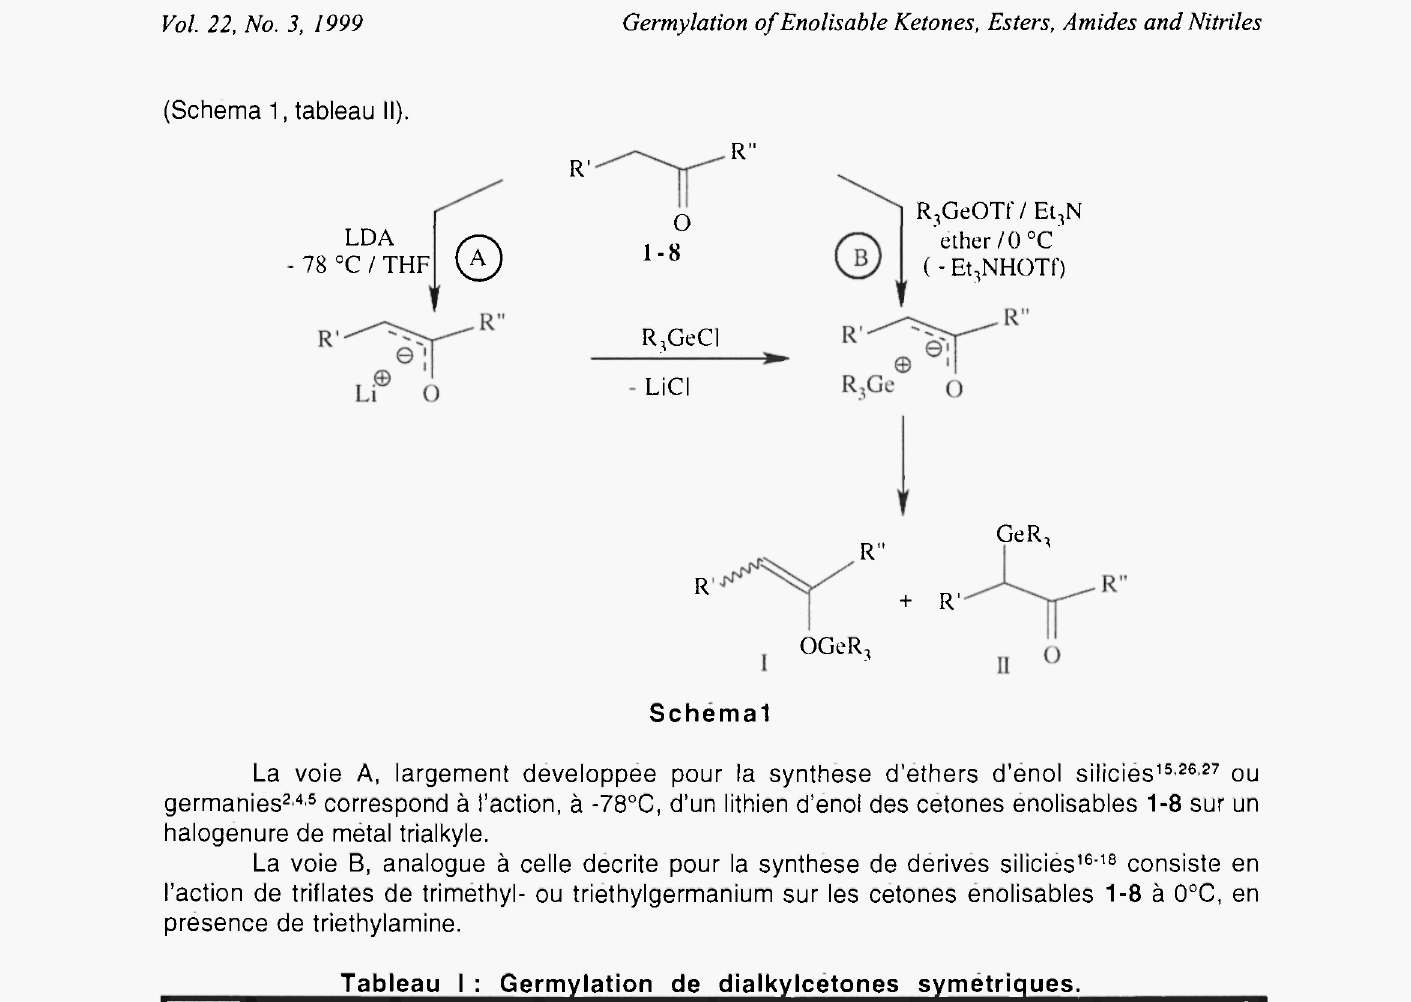
Tableau I : Germylation de dialkylcetones